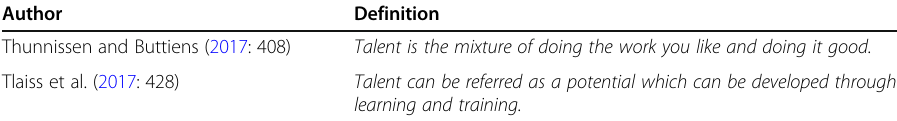
Table 2 Some critical definitions of the notion “ talent ” in the business management